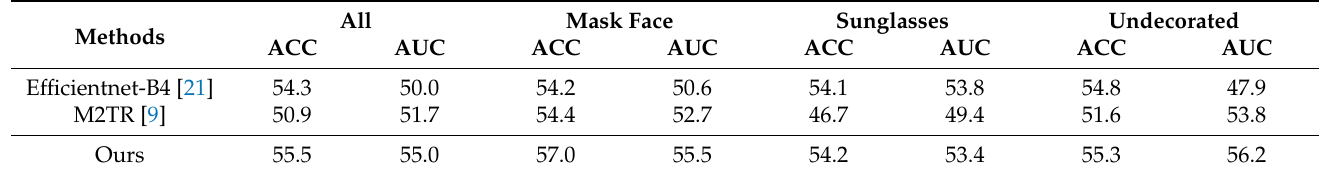
Table 5. Cross-dataset evaluation results on FOFDTD (artificial) dataset (ACC% and AUC%).